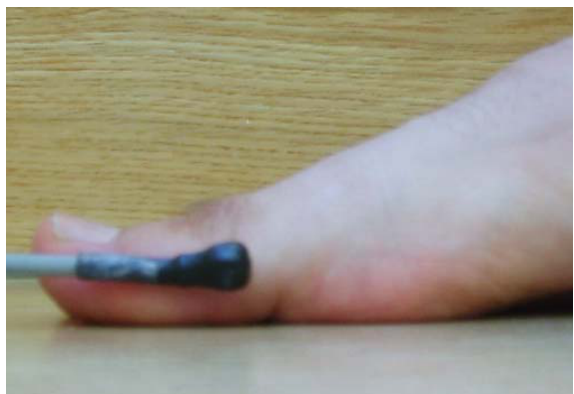
Figure 3. Sensor two. Location placed on the border of the proximal phalanx of the hallux.